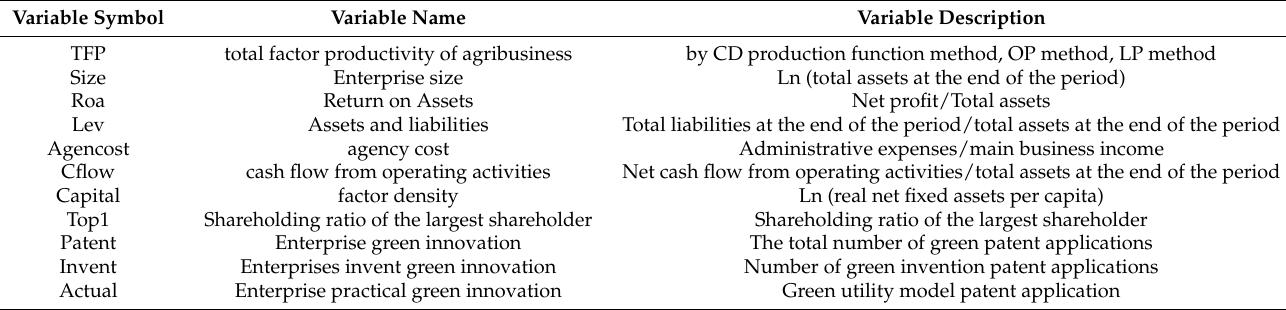
Table 1. Definition of each